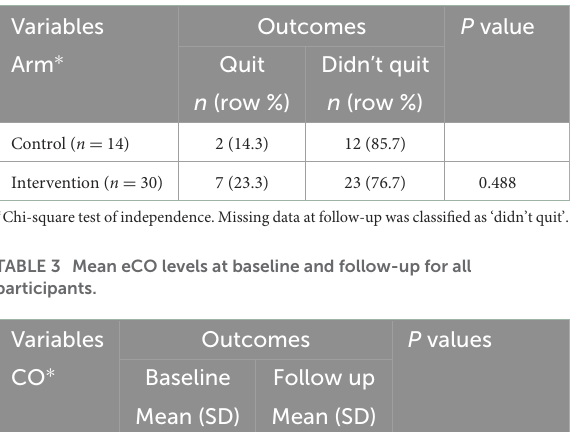
TABLE 2 Quit rates at follow-up among participants compared to non-participants.